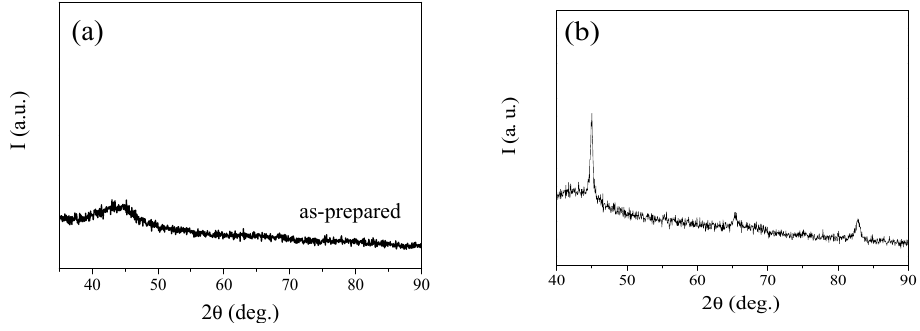
Figure 2. X-ray diffraction (XRD) patterns of as-prepared Fe 70.8 Cu 1 Nb 3.1 Si 14.5 B 10.6 microwires with ρ = 0.59, ( a ), and as-prepared Fe 38.5 Co 38.5 B 18 Mo 4 Cu 1 with ρ = 0.60 ( b ). Reproduced from reference [10] Figure 4. Hysteresis loops of all as-prepared microwires present a rectangular shape typical for Fe-rich